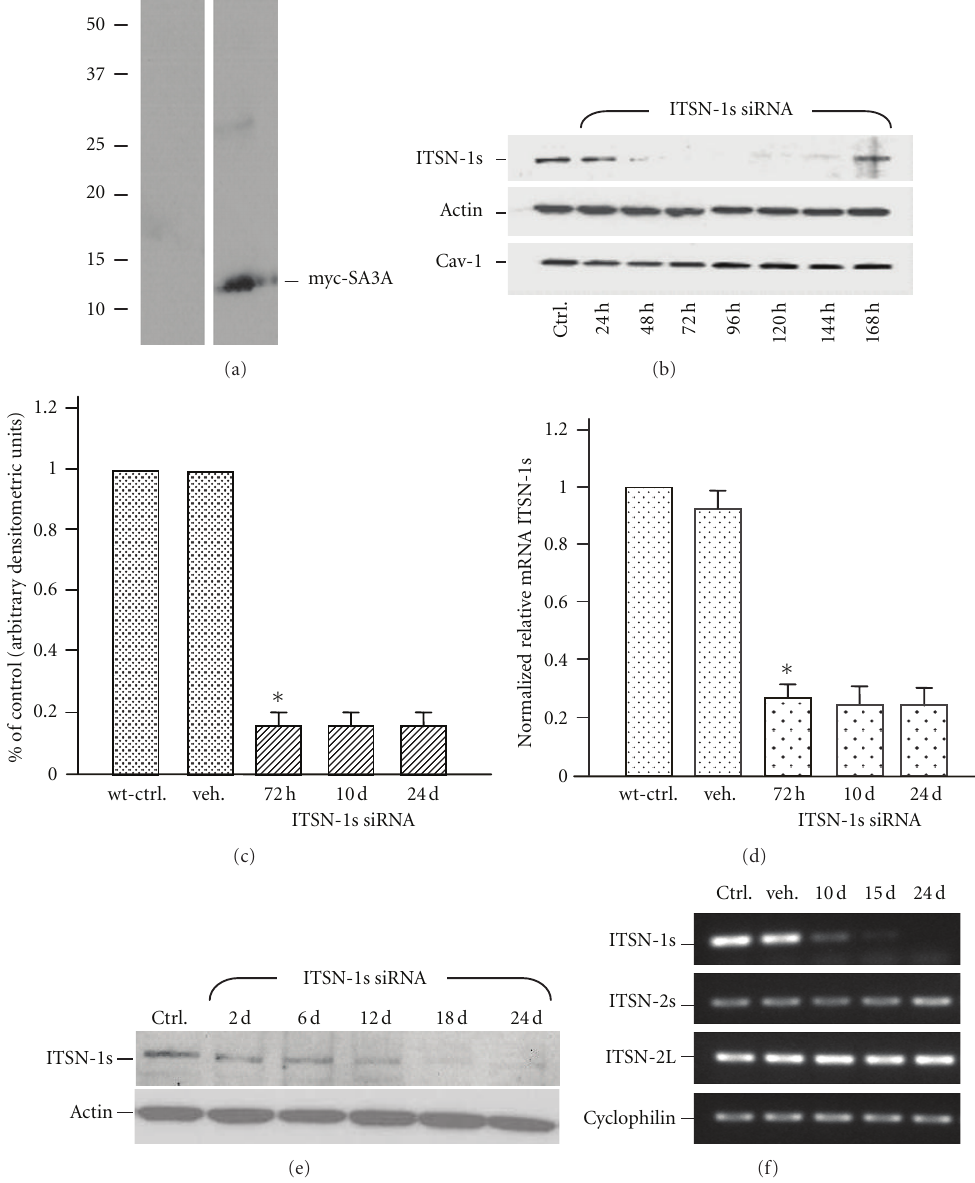
Figure 1: Experimental modulation of ITSN-1 expression in mouse lungs. (a) Myc-SH3A domain of ITSN-1s is e ffi ciently expressed in mouse lungs, at 48 h alter delivery of the plasmid cDNA/liposome complexes. Mouse lung lysates (70 μ g total protein/lane) of control